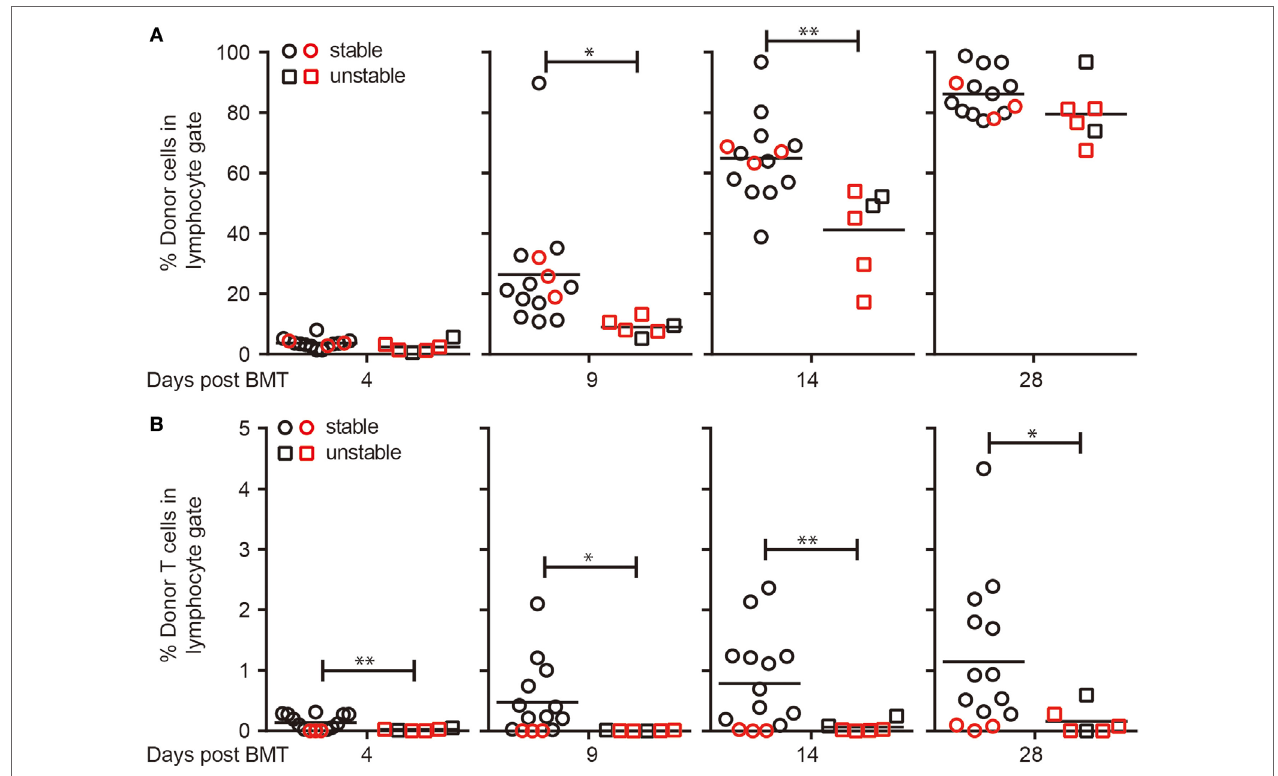
FigUre 6 | Loss of chimerism is significantly associated with lower early levels of chimerism and donor T cells. Non-obese diabetic (NOD) recipients were conditioned with donor-specific transfusion (DST) (day − 10; using C3H or FVB splenocytes), cyclophosphamide (day − 8), anti-CD4/8/90 monoclonal antibodies (day − 6 and every 5 days until day 14), busulfan (day − 1), and bone marrow cells (BMC) (day 0, 20 × 10 6 ; using BMC from same donor strain as the DST). Peripheral blood lymphocytes (PBL) were harvested before each treatment to evaluate the donor cell components in the lymphocyte gate. Comparison of early levels of chimerism (a) and donor T cells (B) in recipients that maintained stable chimerism ( n = 14) and those had unstable chimerism ( n = 6). Black: FVB → NOD; red: C3H → NOD. * p < 0.05, ** p < 0.005, Student’s t -test with Welch’s correction when variances were significantly